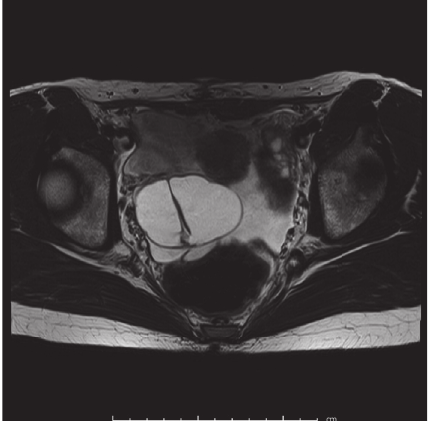
Figure 3: Pelvic magnetic resonance imaging (T2-weighted image) beforethethirdsurgeryofCase 2.Rightovariantumorsaredetected (multiple cystic, 6.3 × 4.9 cm in